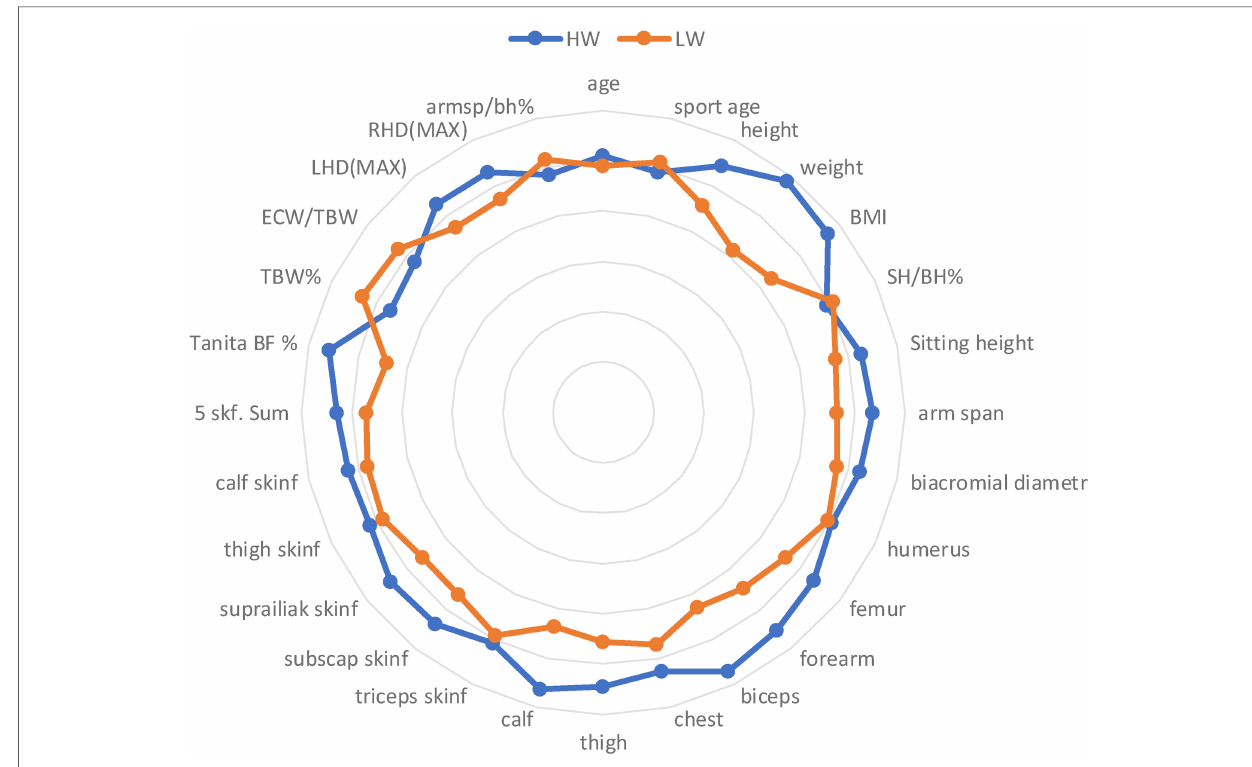
FIGURE 4 Radar graph with markers to present intergroup differences in females.